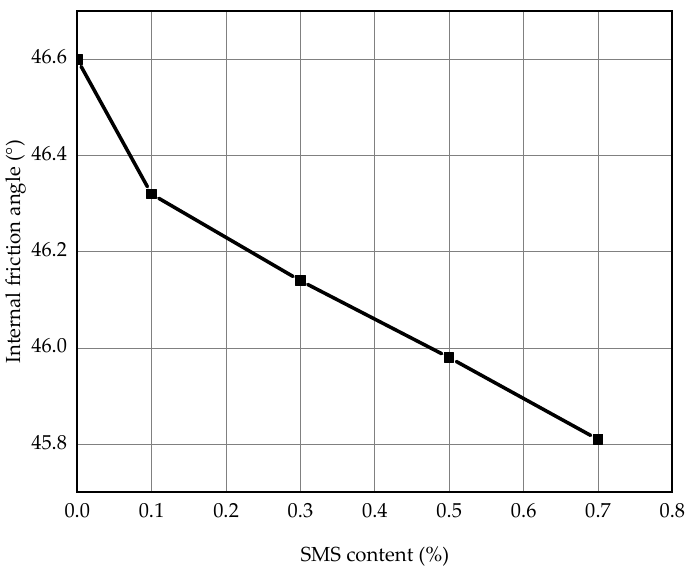
Figure 7. The change of cohesion force with SMS content.